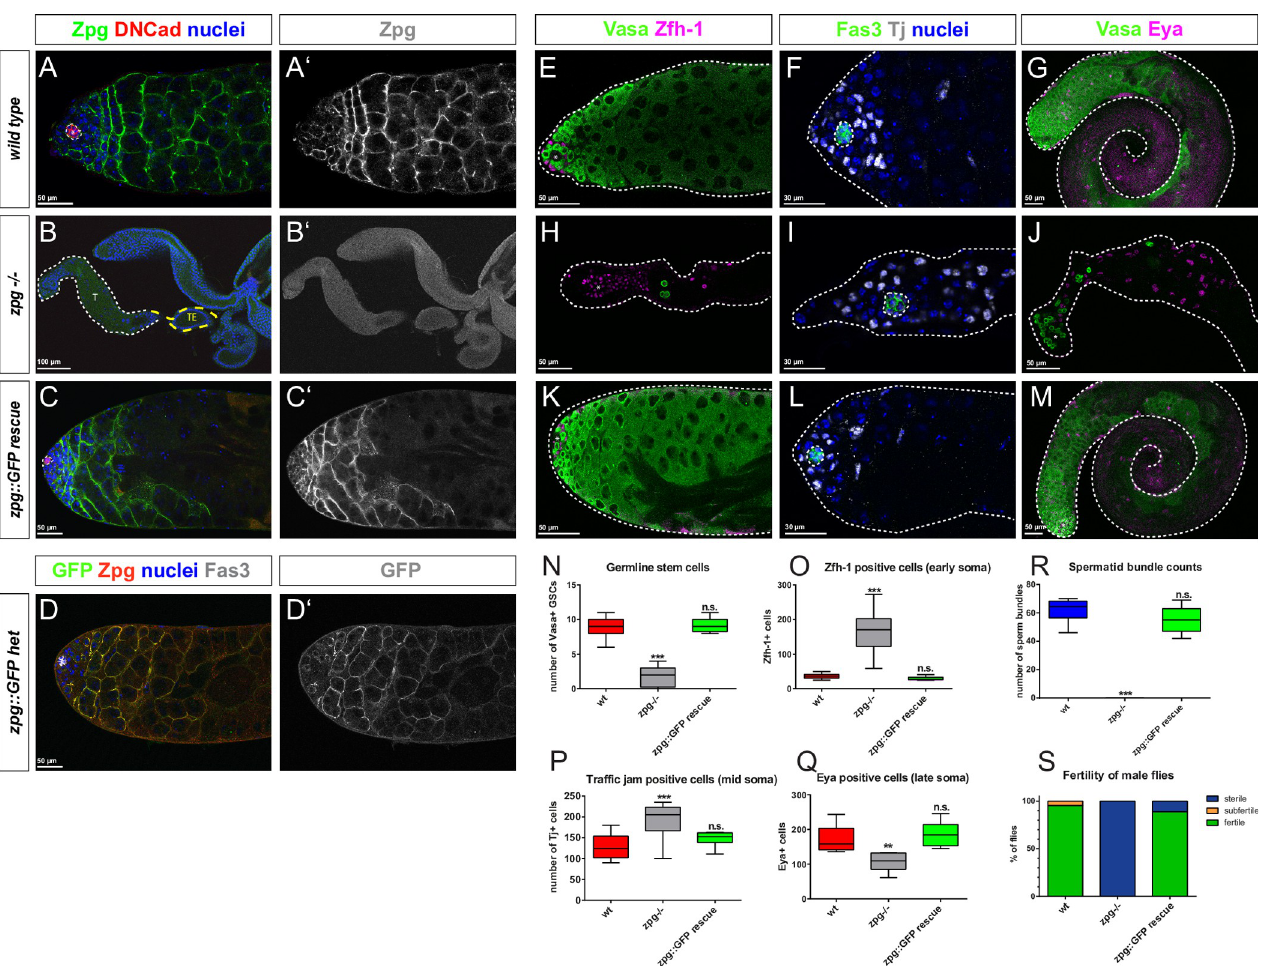
Fig 2. Zpg function can be fully restored by introducing a GFP-tagged genomic rescue construct into the zpg null mutant background. Zpg staining (green in A-C; single channels depicted in grey in A’-C’) is strongly enriched at the soma-germline boundary in the wild type (A, A’), but cannot be detected in the rudimentary testes of zpg null mutants (B, B’). Wild type like distribution of Zpg can be seen in flies having the zpg ::GFP GR (Genomic rescue) construct in the zpg null mutant background (C, C’). Hubs are marked by DN-Cadherin in red, nuclei are labeled in blue (A-C). Heterozygous expression of zpg ::GFP GR (D, D’) reveals strong colocalization of the transgenic construct (GFP, green) and endogenous Zpg (red). Fas3 labels the hub. D’ shows single channel GFP signal at germ cell membranes in grey. Compared to wt (E, G), zpg null (H, J) mutants show a strong reduction of mitotic Vasa+ germ cells (green), indicating an early arrest in germ cell differentiation. In contrast, the number of germ cells (green) in zpg ::GFP GR rescue flies (K, M) is indistinguishable from wt. The number of early somatic cells labeled by markers Zfh-1 (cyst stem cells and immediate daughter cells; magenta) and Tj (grey) is, compared to wt (E, F), greater in testes of zpg null mutants (H, I), but unaffected in zpg ::GFP GR (K, L). Number of cells expressing the late somatic cell marker Eya (magenta) is, compared to wt (G), lower in zpg null mutants (J), but unaffected in zpg ::GFP GR testes (M). Quantification of (N) the number of germline stem cells (GSCs, defined as single Vasa+ cells contacting the hub), (O) Zfh-1-positive cells, (P) Tj-positive cells, (Q) Eya-positive cells, (R) spermatid bundles, and (S) fertility in wildtype, zpg null mutant, and zpg ::GFP GR rescue flies. Scale bars represent 30–100 μ m, as indicated above them. p-values are for difference from wildtype and indicated by asterisks with � p < 0.05, �� p < 0.01, ��� p < 0.001. Second, germ cell differentiation was assessed by labelling germ cells and performing cell counts in wildtype, zpg null mutant, and zpg ::GFP GR testes. The protein Vasa is a marker that labels germ cells from the germline stem cells (GSCs) stage to the spermatocyte stage [57]. In the wildtype (Fig 2E and 2G), Vasa mostly labels the anterior part of the testis, which harbors the mitotic-stage germ cells. In comparison, only a few Vasa expressing cells are seen in testes of mutants lacking Zpg expression (Fig 2H and 2J), which is in agreement with previously pub- lished data [51,53] and indicates a profound loss of germ cells in the mutants. Furthermore, in wildtype testes, both Vasa staining (Fig 2E and 2G) and Zpg staining (Fig 2A and 2A’) stain the